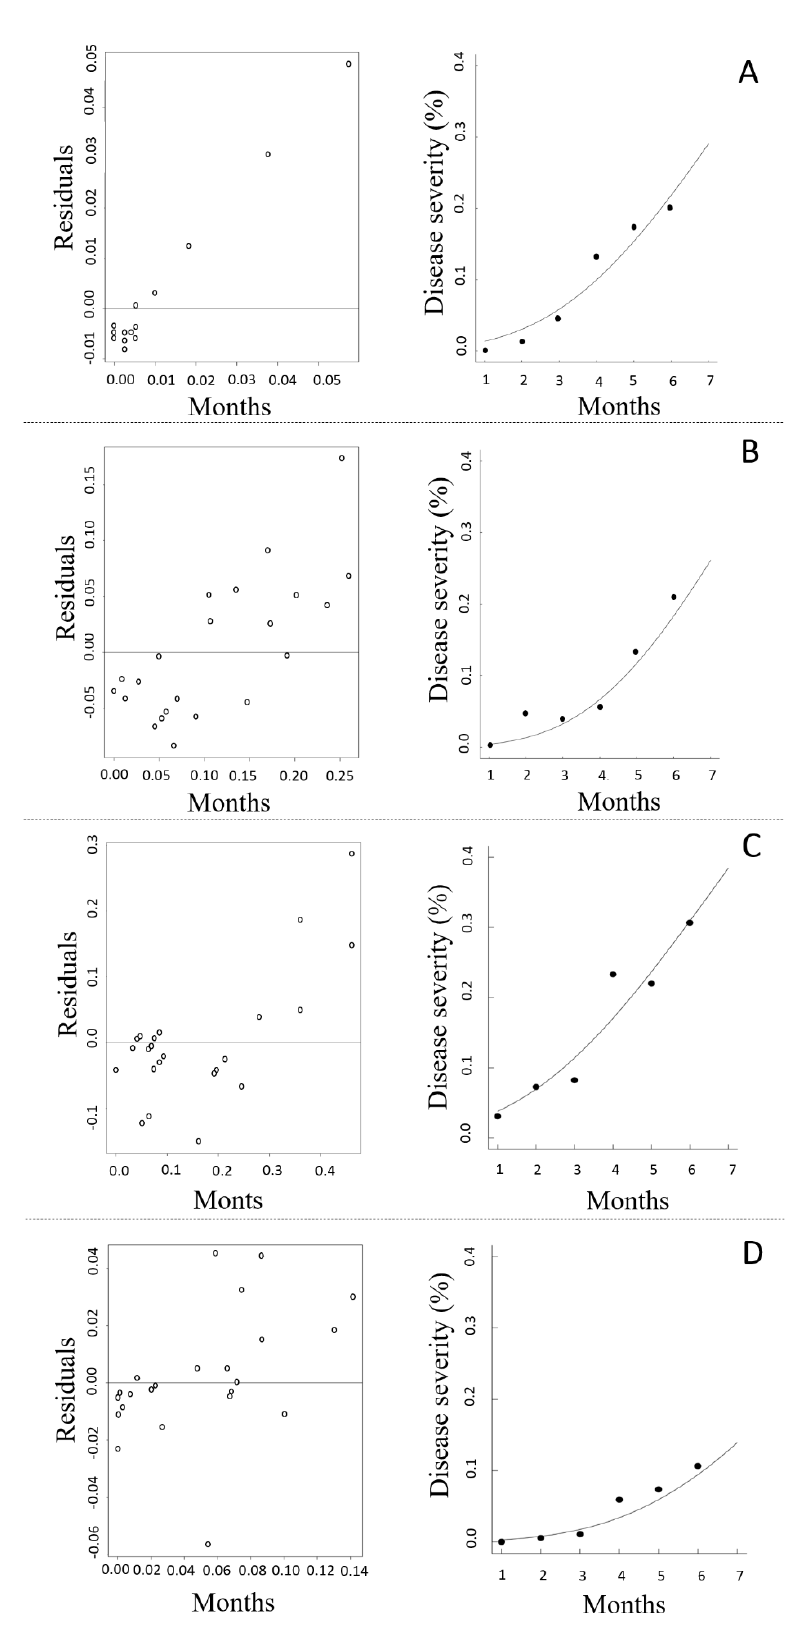
Figure 4. Dispersion plot of residuals and disease severity fitted by the Gompertz model in the months from February to August 2017 for clones ( A ) 34, ( B ) 25, ( C ) 27, and ( D ) 35. Dispersion plots are on the left and disease progress on the right-hand side.